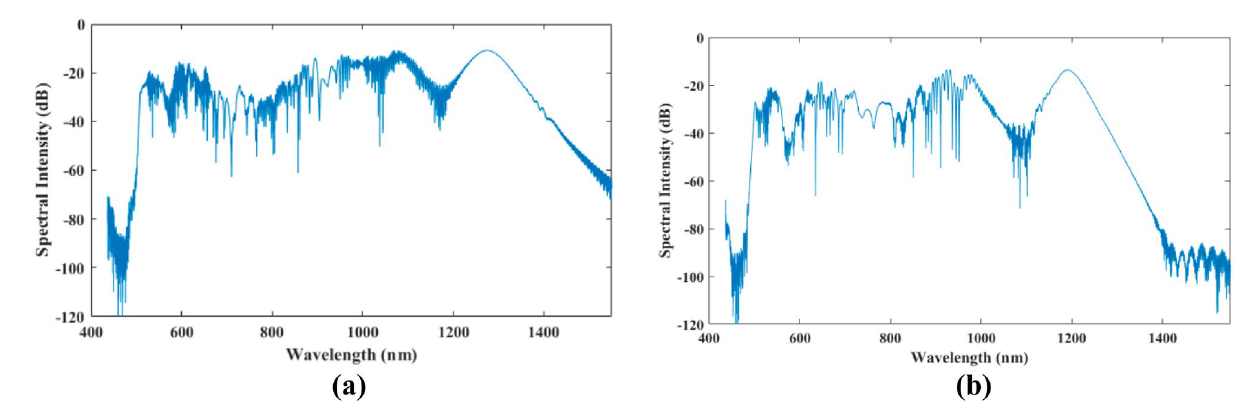
Figure 1. Simulation results for the quantum mechanical ( a and b ) and classical treatment (c and d) of the supercontinuum generation, SCG, along the first 15 cm of a PCF fiber. Photons generated at wavelengths from 400 nm ( a ) to 1450 nm in a quantum treatment and ( c ) to 1350 nm in a classical treatment of SCG. Time development of the input pulse is shown in ( b ) and ( d ) with respect to the delayed pulse in a quantum and classical models, respectively.